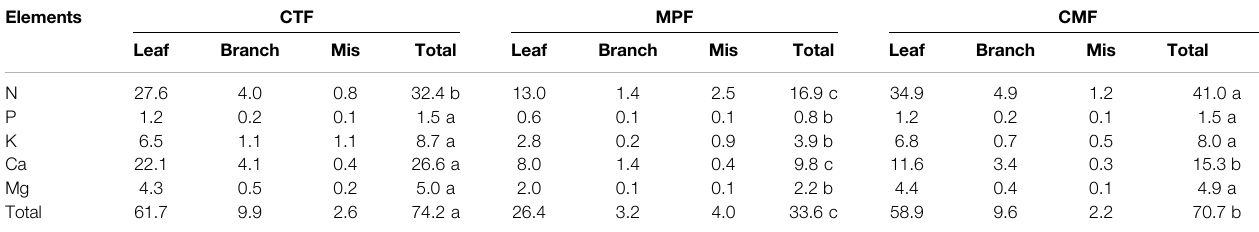
TABLE 4 | The annual return of macronutrients from litterfall components in the three examined subtropical forest types (kg · ha − 1 · yr − 1 ). Elements